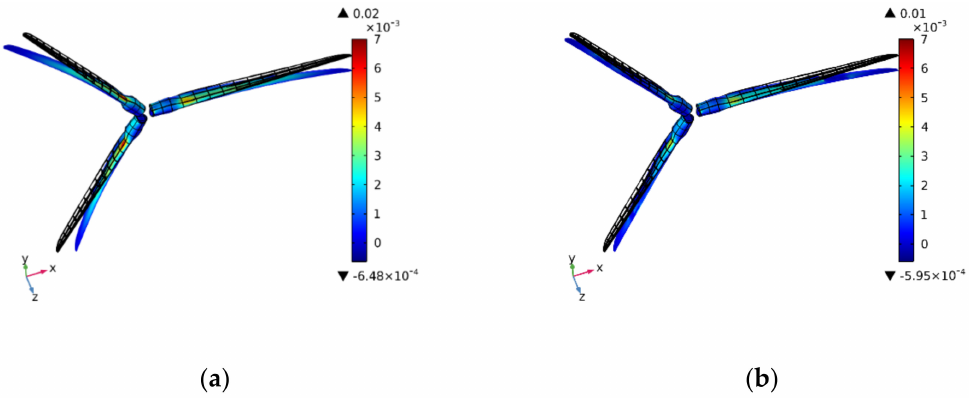
Figure 11. Blade strain comparison: ( a ) Blade without RCC; ( b ) Blade with RCC connected at 2 L /3. The stress response of RCC is displayed in Figure 12. When the wind direction is parallel with rotor surface, only two of reinforcing cables are in